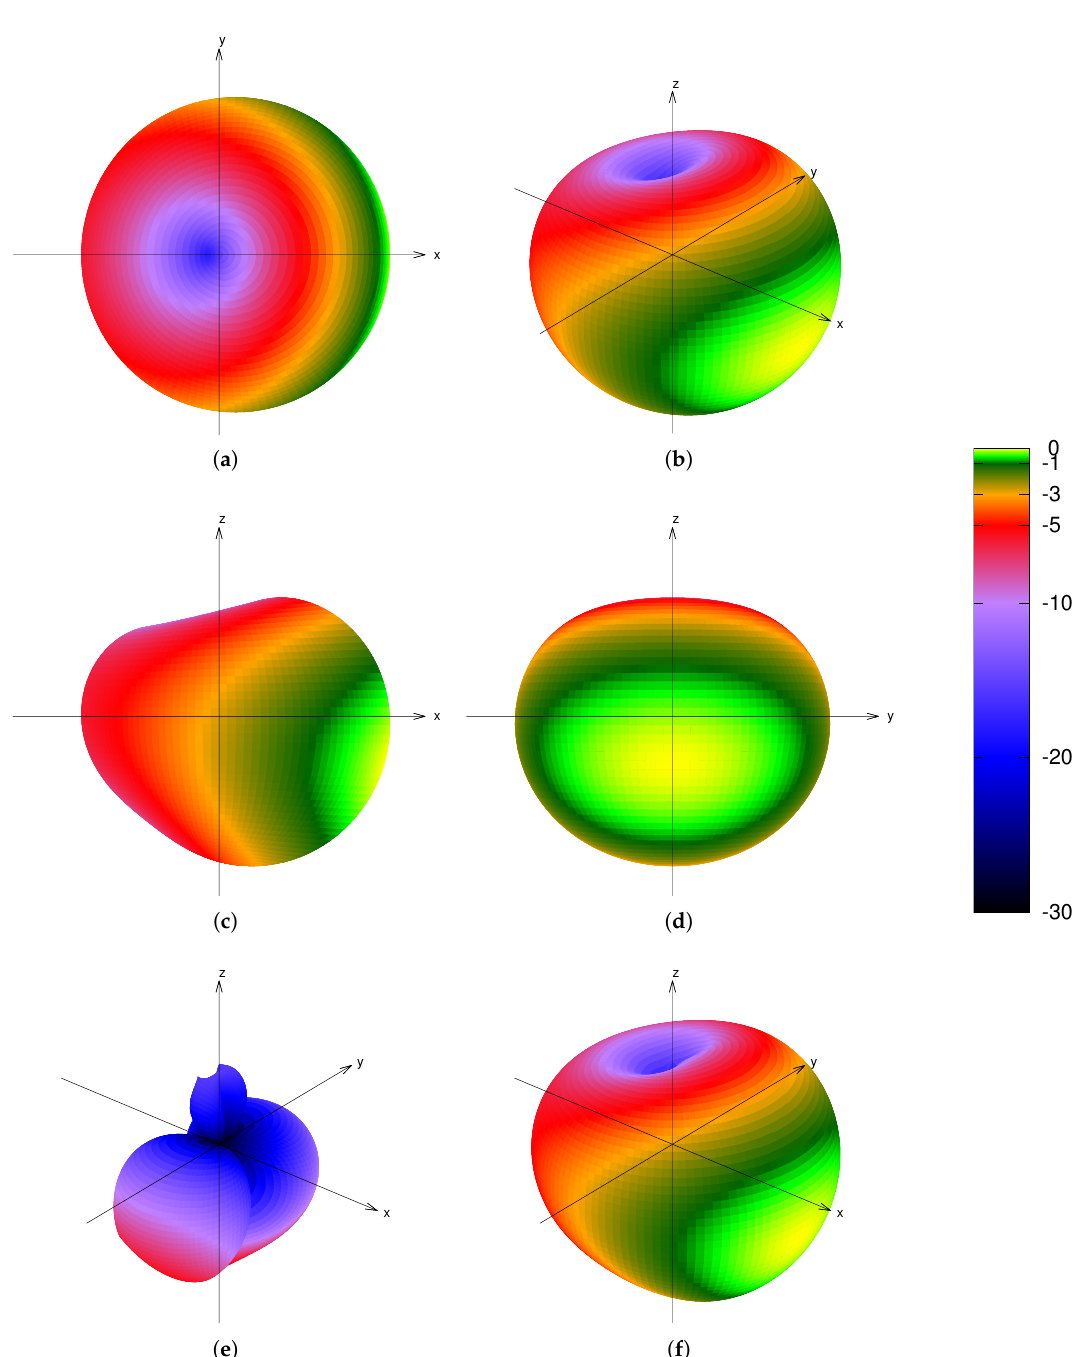
Figure 6. Free-space, far-field 3-dimensional simulated pattern (dB) for the Seal Rocks design. ( a ) shows the plan view while ( c , d ) show the side and front elevations of the pattern. The remaining oblique views, ( b , e , f ) show the radiation patterns for the combined, horizontal and vertical polarisations respectively. The images show relative directional antenna gain and are mapped with the ( − 30 dB,0 dB ) (cid:55)→ r = ( 0,1 ) radius of the unit sphere. Gain is normalized such that 0 dB (cid:55)→ − 14.32